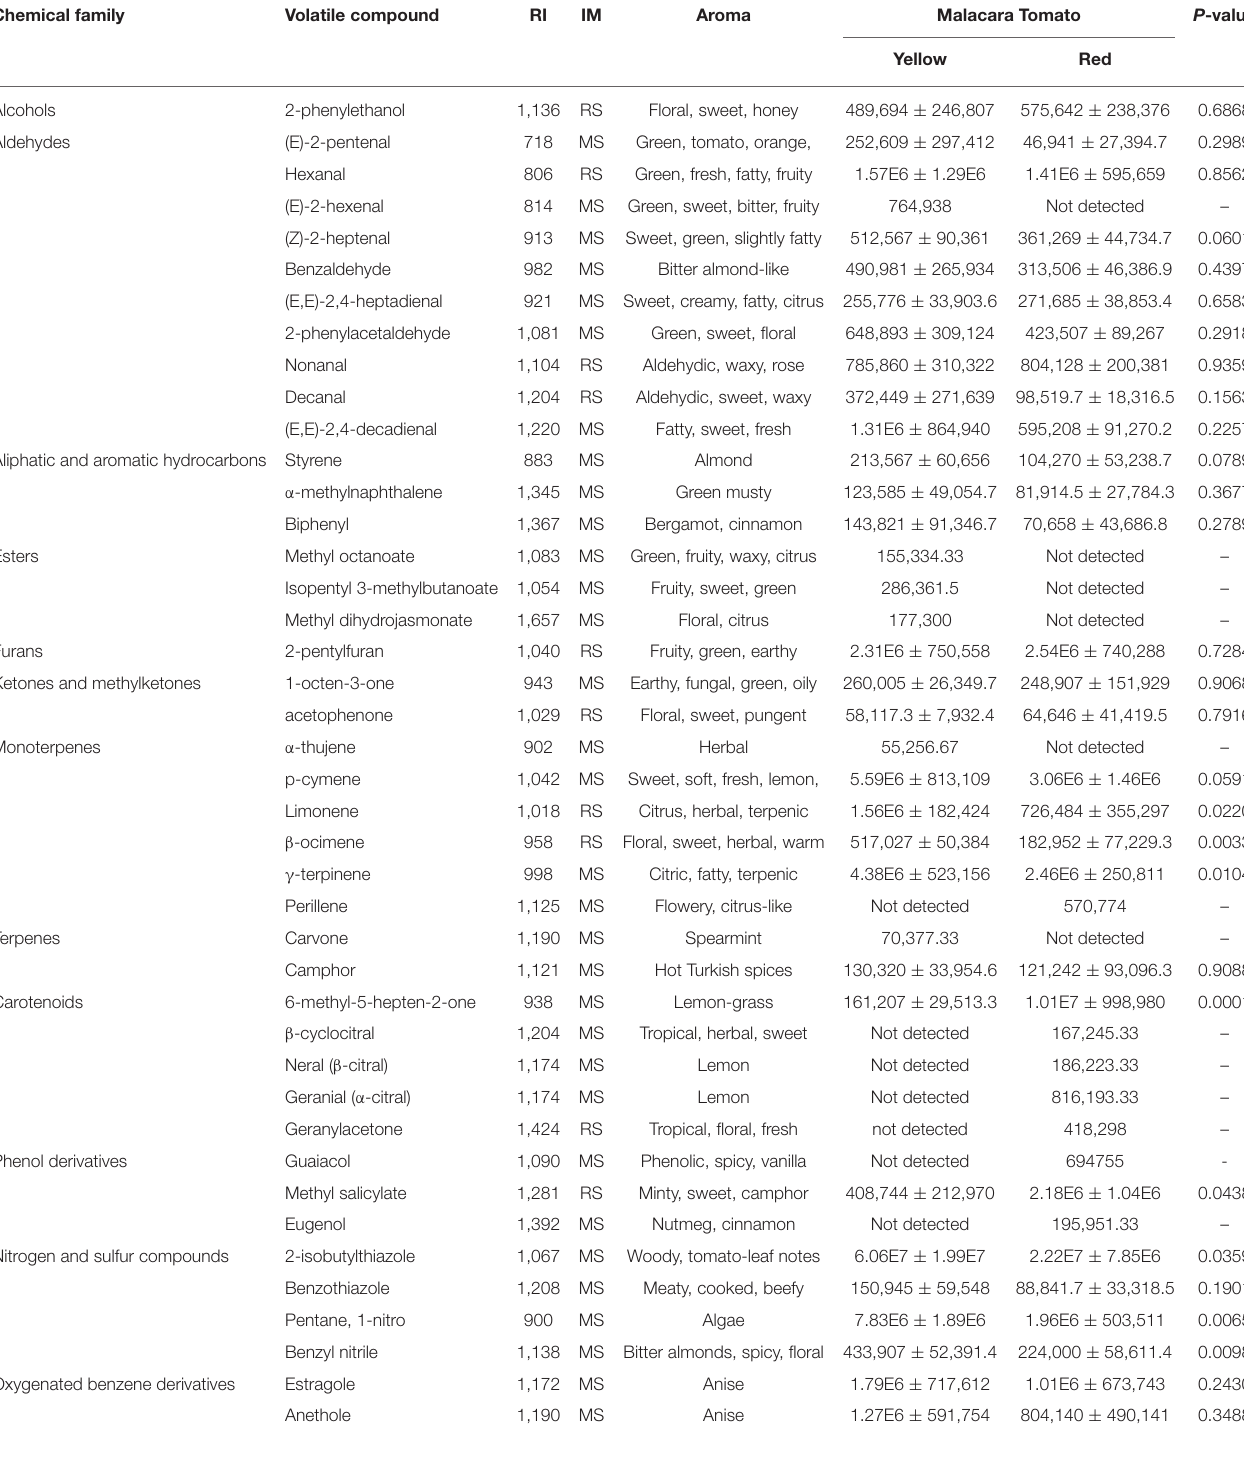
SD, n 3 and p -value, for the two types of Malacara ± =